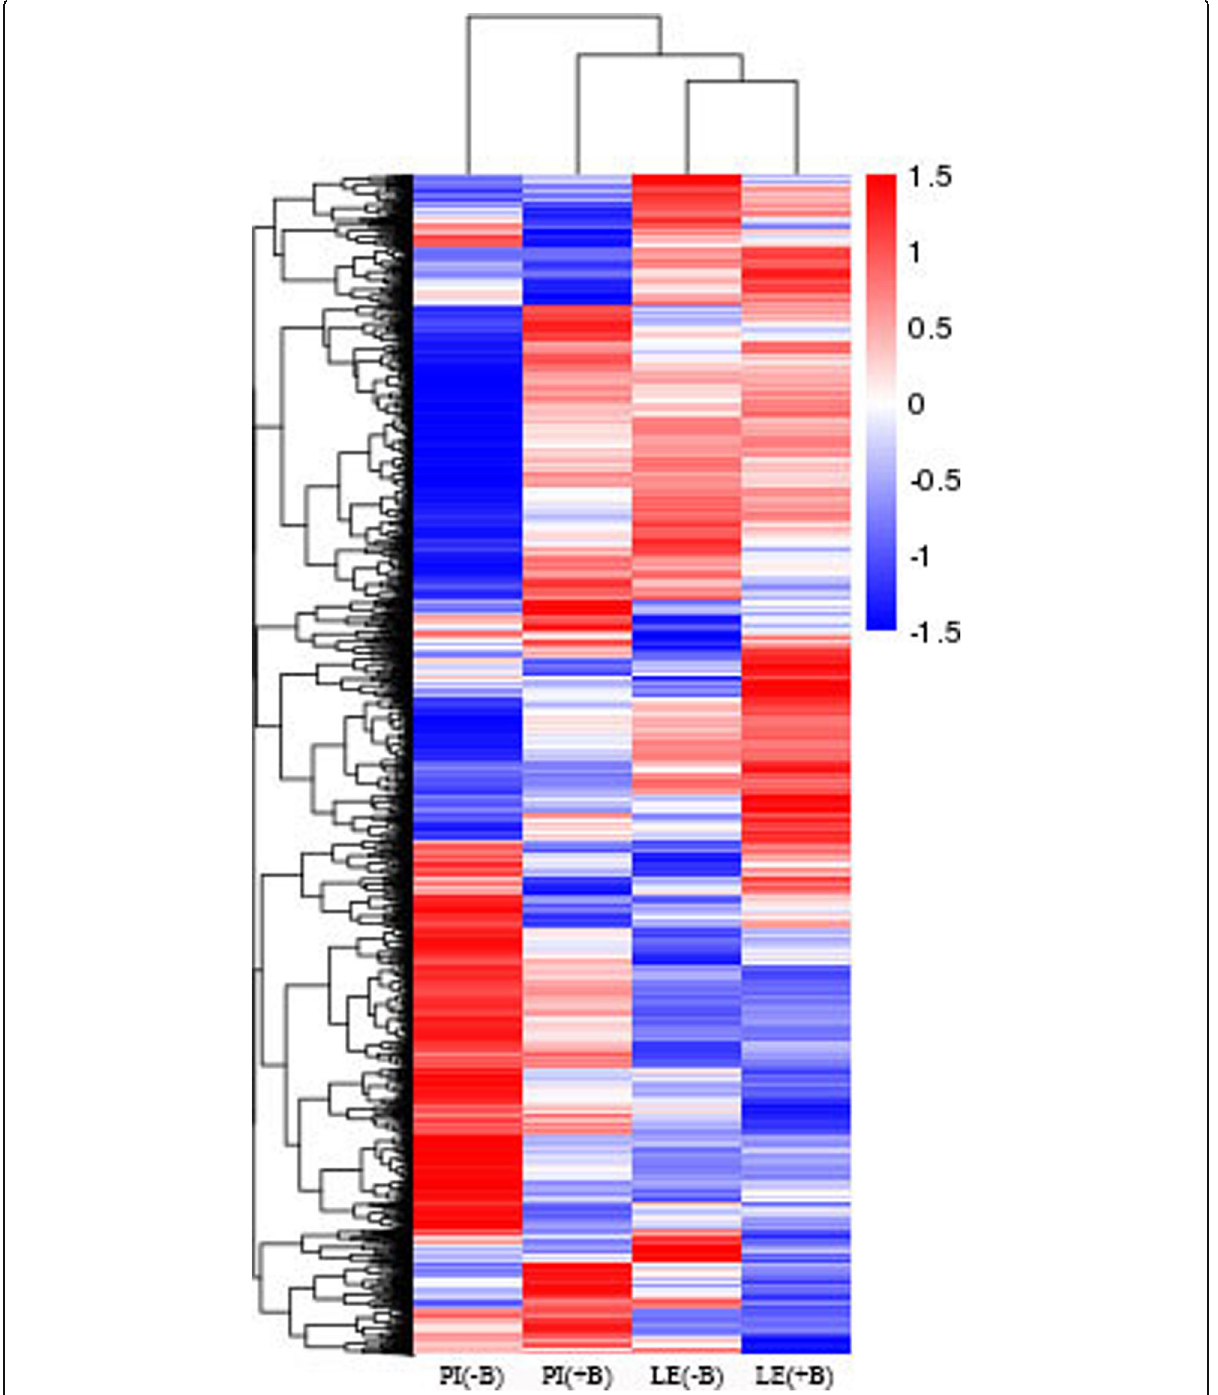
Fig. 2 Hierarchical cluster analysis of the DEGs. The color key represents FPKM-normalized log2-transformed counts. PI(+B) and LE(+B) represent the PI and LE accessions treated with barnyard grass root exudates. PI( − B) and LE( − B) represent the corresponding no-induction specifically 12 groups in the biological process category Functional classification by GO (Fig. 4a), 12 groups in the cellular component category Based on the GO analysis, the 12,505 DEGs of PI(+B) vs. (Fig. 4b), and eight groups in the molecular function PI( − B) and 6374 DEGs of LE(+B) vs. LE( − B) were classi- category (Fig. 4c). fied into three categories with 32 functional groups,